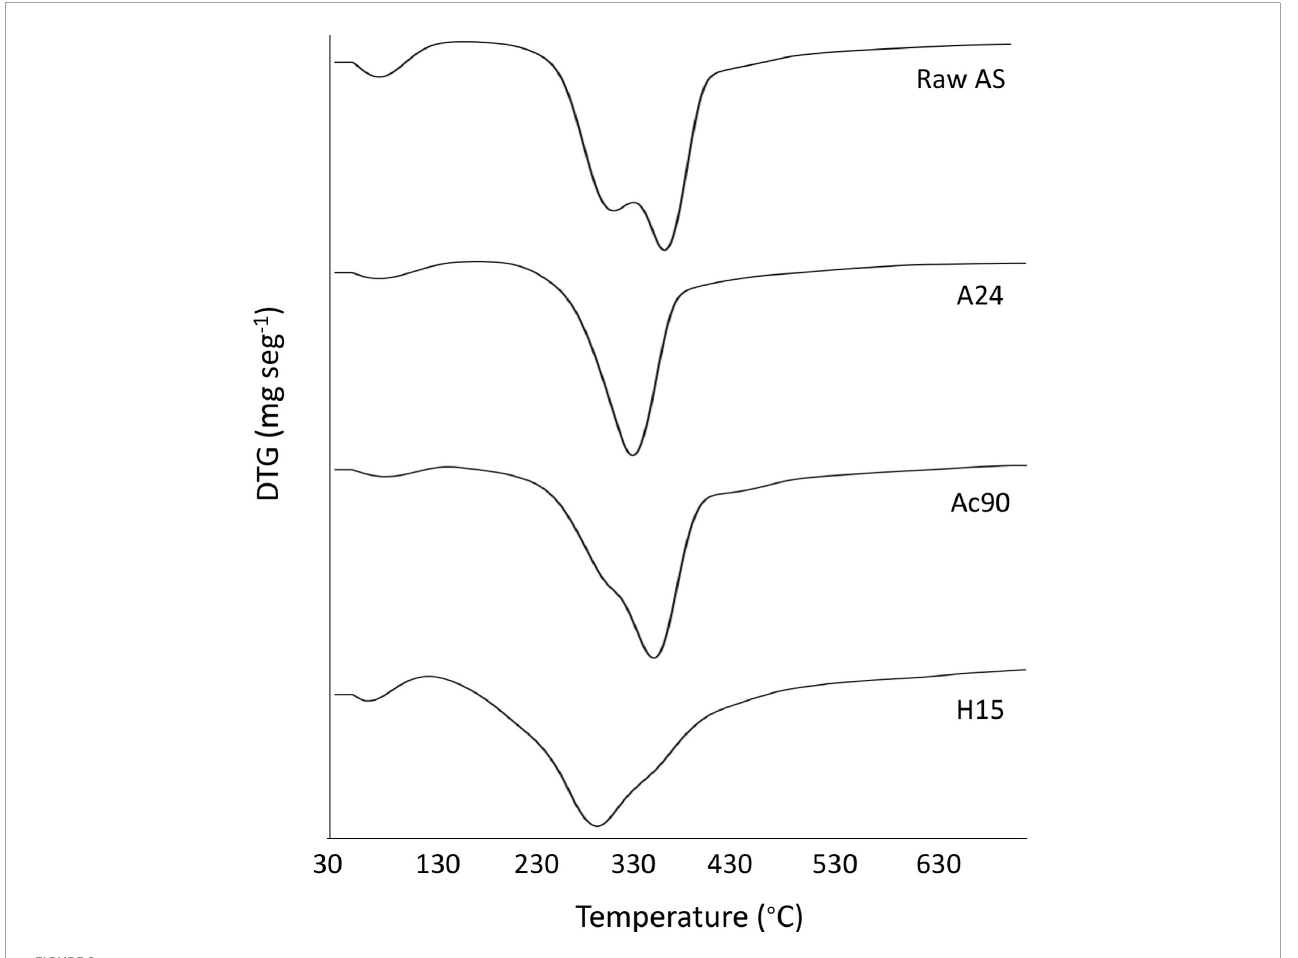
FIGURE2 DTG curves of raw AS, A24, Ac90, and H15